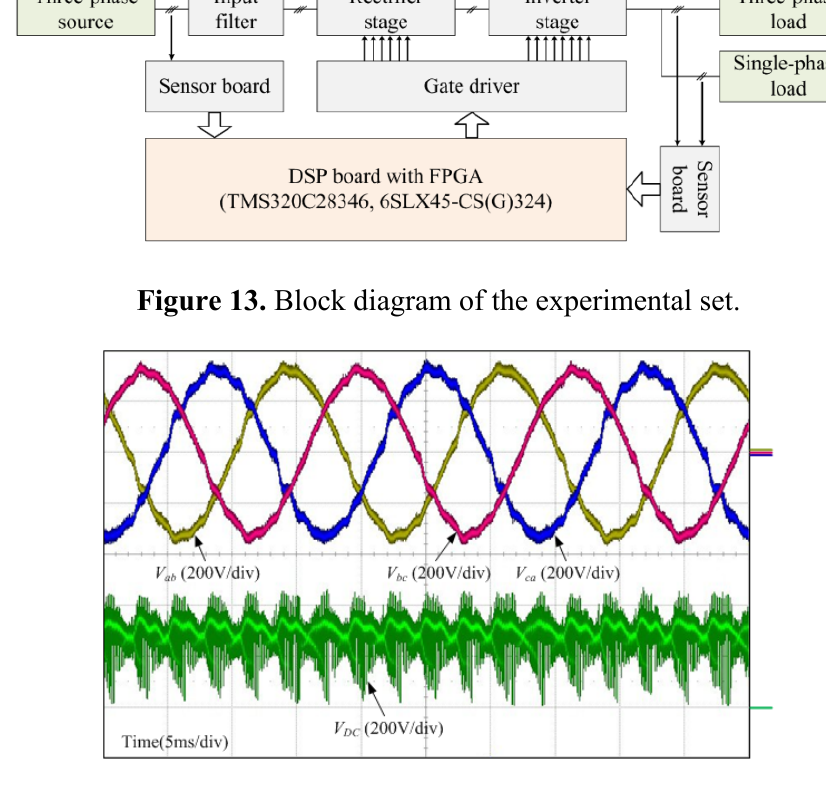
Figure 14. Experimental waveforms of the three-phase input line-to-line voltages and the DC-link